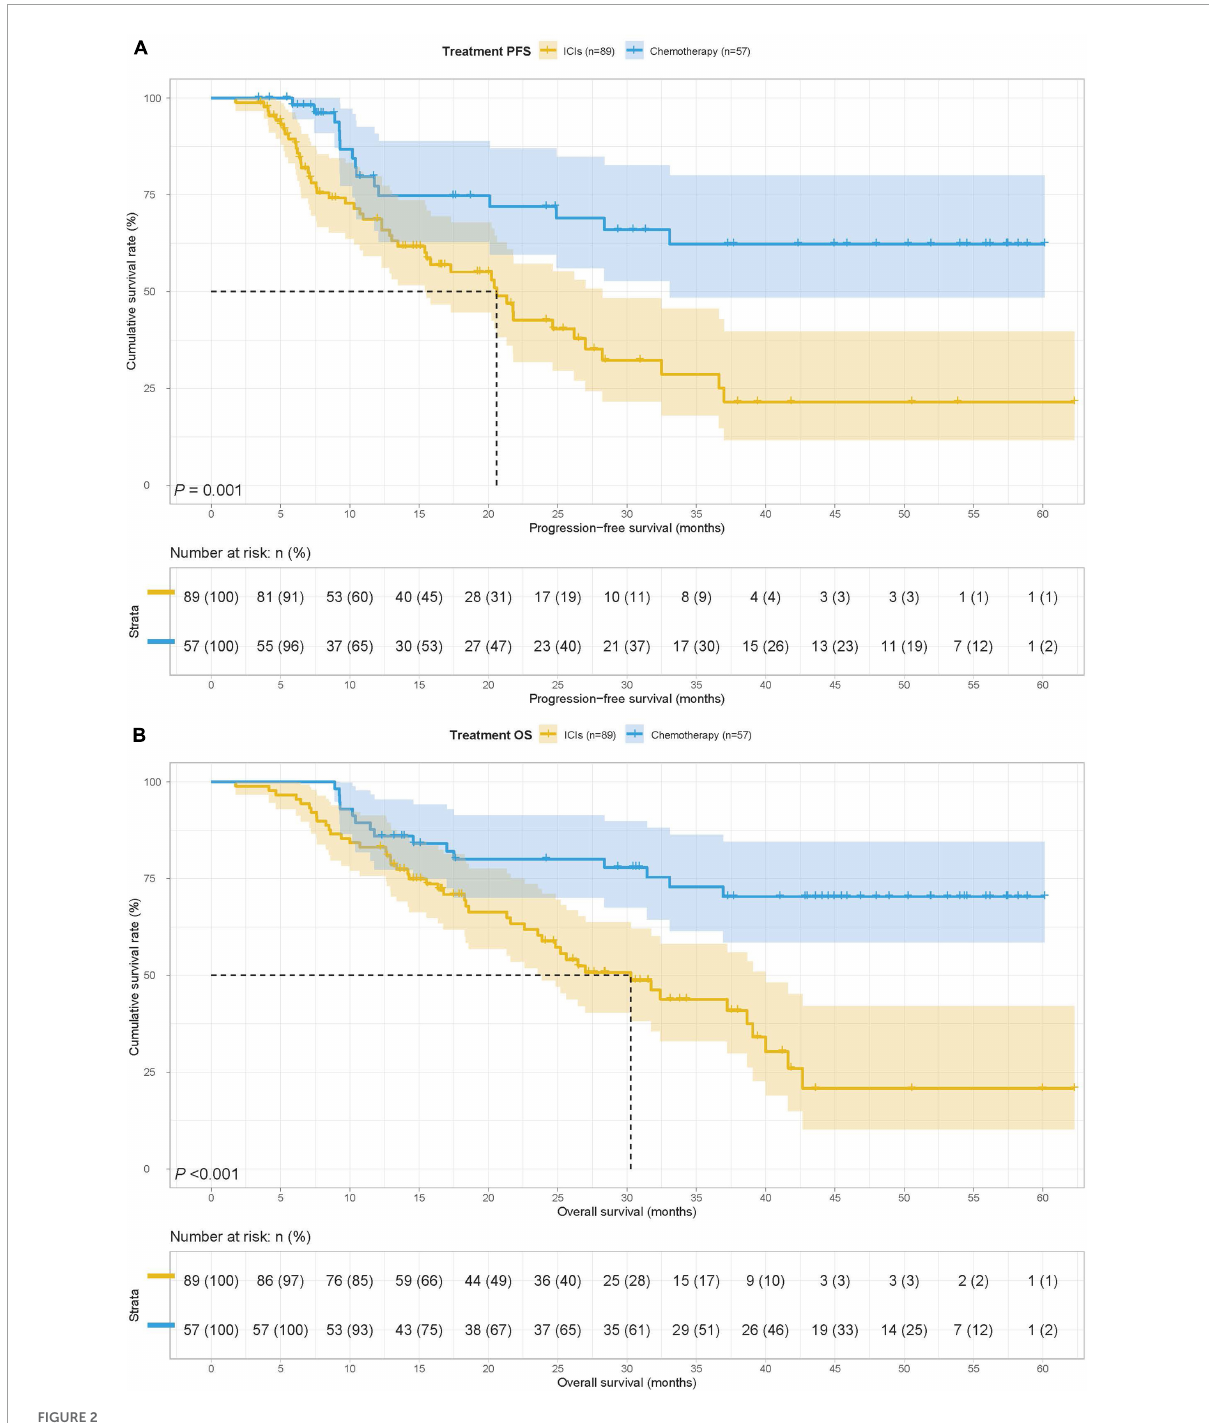
FIGURE2 Treatment related survival curve of (A) PFS and (B) OS in all patients.